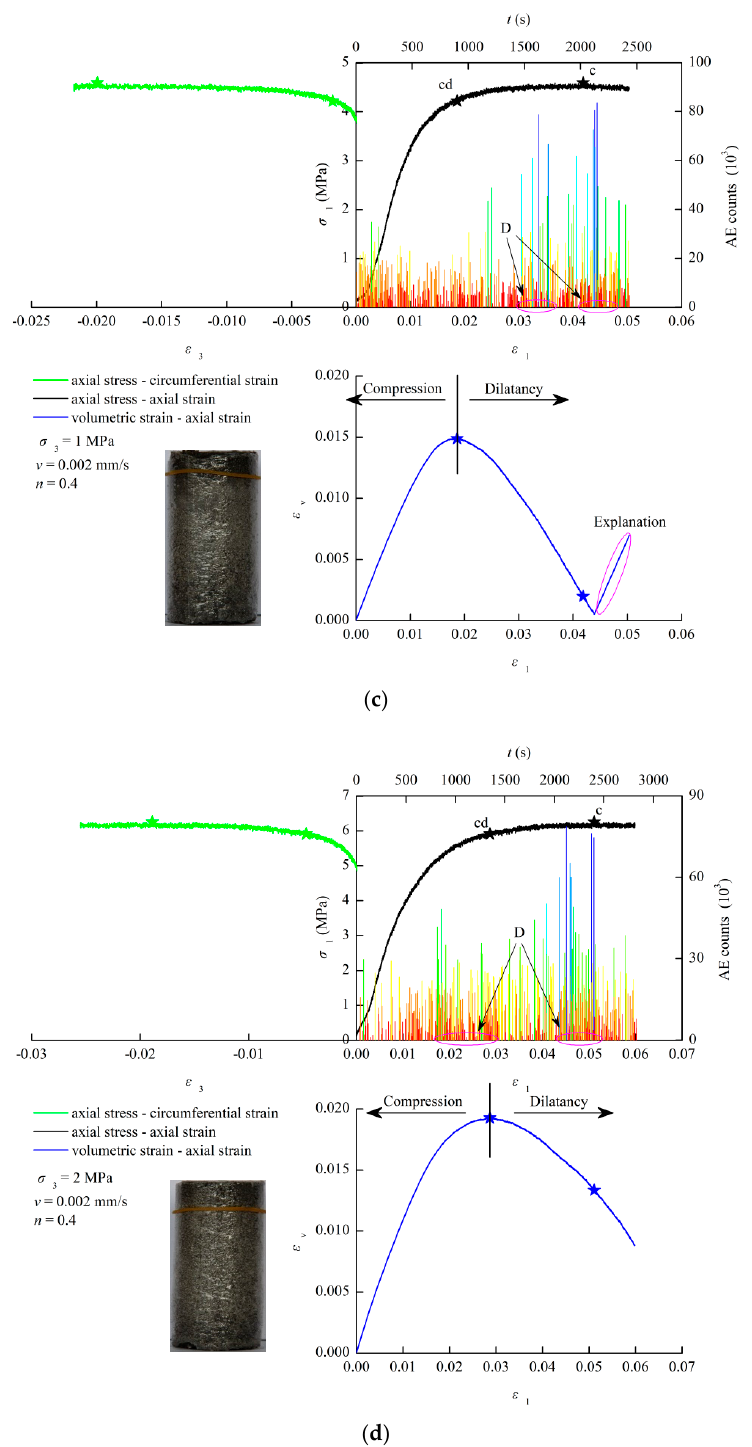
Figure 5. Stress–strain ‐ AE curves of CPB specimens under different confining pressures. σ 3 = 0 MPa ( a ); σ 3 = 0.5 MPa ( b ); σ 3 = 1 MPa ( c ); σ 3 = 2 MPa ( d ).